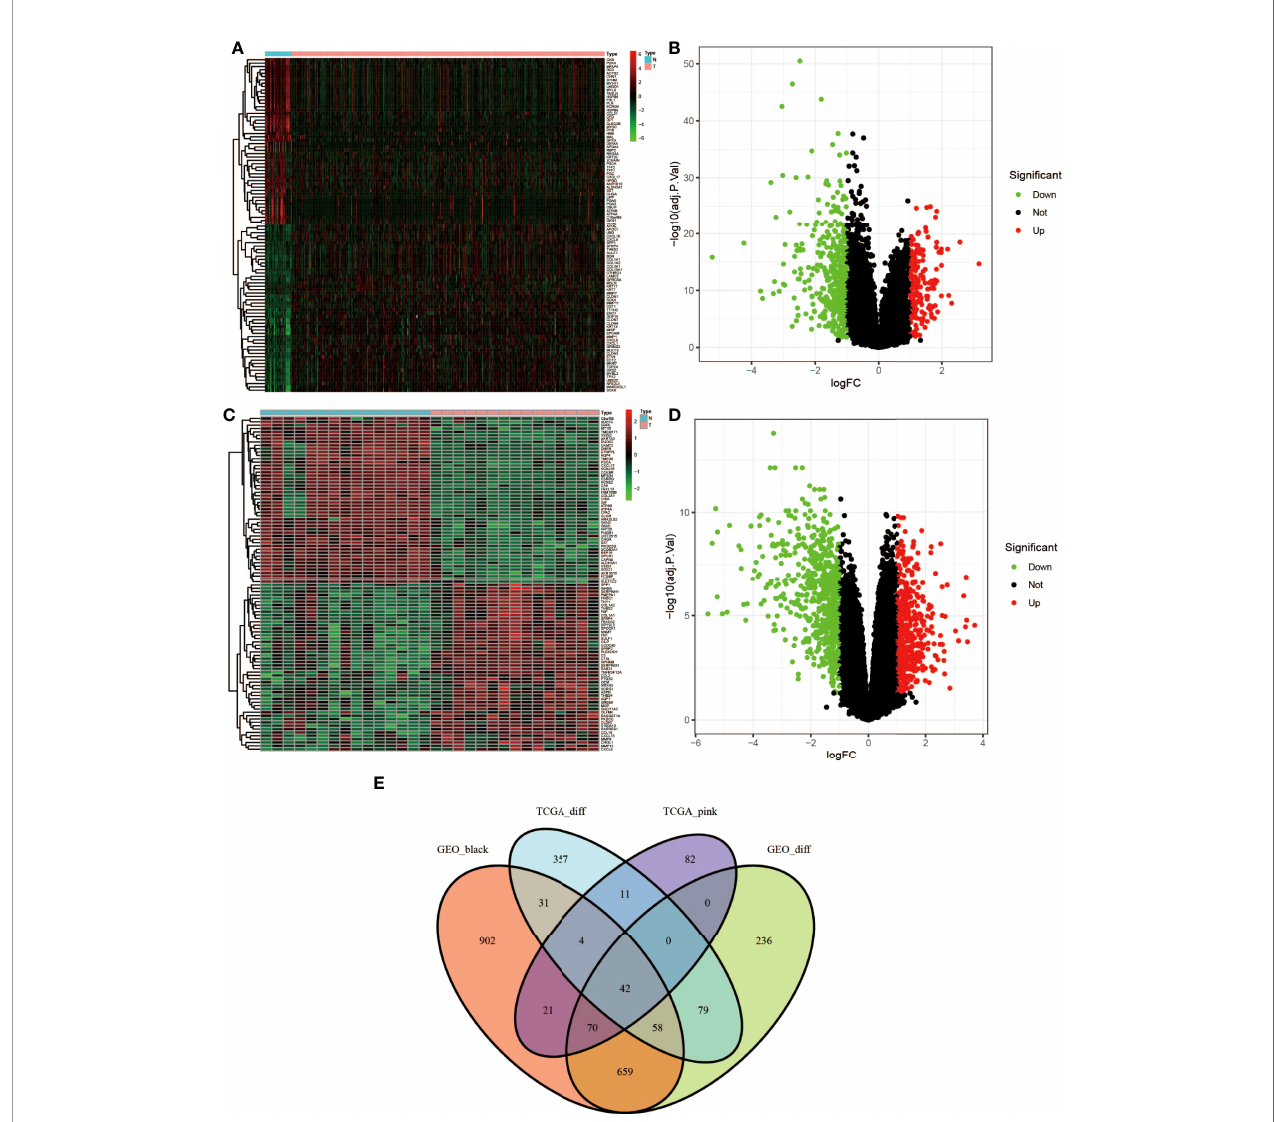
FIGURE 4 | Identi fi cation of differentially expressed genes (DEGs) of the TCGA and GSE118916 datasets of STAD with the cutoff criteria of |logFC| ≥ 1.0 and adj. P < 0.05. (A, B) Volcano plot of DEGs in the TCGA dataset. (C, D) Volcano plot of DEGs in the GSE118916 dataset. (E) The Venn diagram of genes among DEGs and co-expression module. In total, there were 42 overlapping genes in the intersection of DEGs and two co-expression